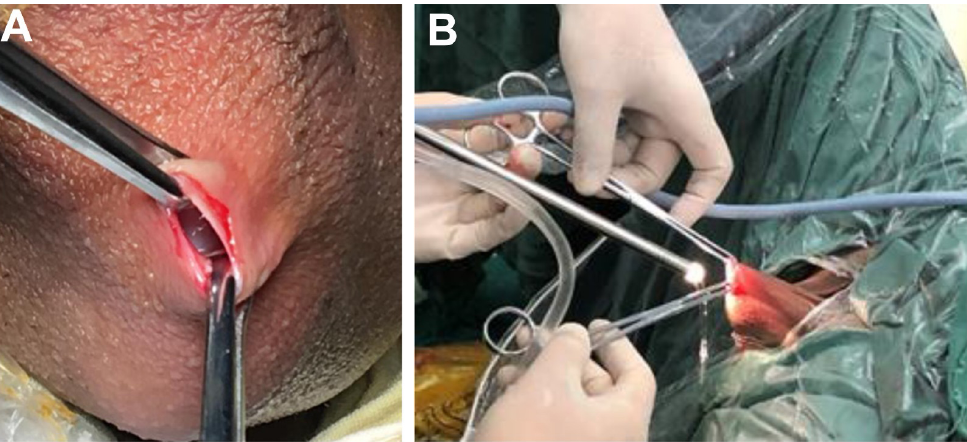
Fig. 1. Scrotoscopic procedure. (A) Two Allis clamps were secured at the edge of the scrotal incision to avoid perfusion fluid leakage through the incision into the interlayer of the scrotal wall. (B) The scrotoscope was inserted into the perididymis cavity.